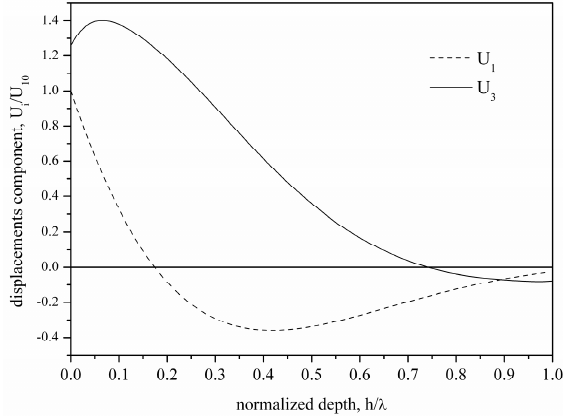
Figure 4. Variation of the normalized vertical and longitudinal displacement components with depth for the Rayleigh-like wave propagating along the <110> direction of the (001) plane of 3C-SiC at velocity v = 7060 m/s.